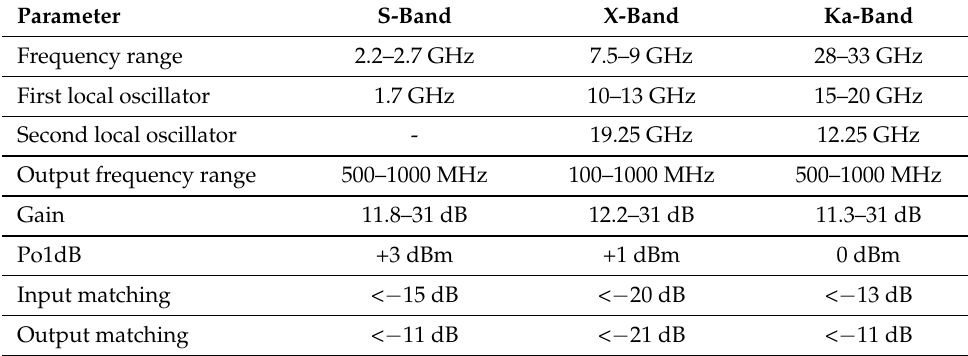
Table 4. Summary of downconverter